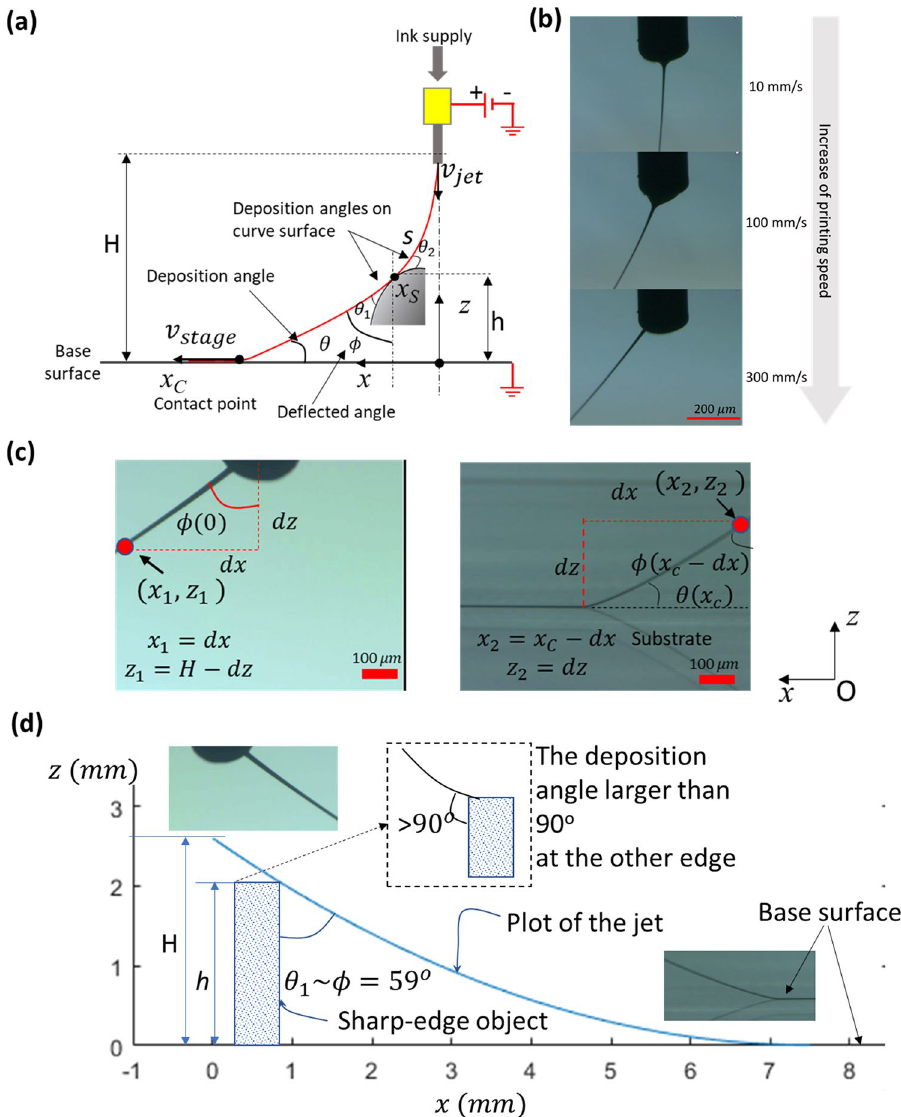
Figure 2. NFES jet deflection for 3D surface patterning. ( a ) NEFS jet deflection model for 3D surface printing. ( b ) Influence of printing speed on jet deflection shape. ( c ) Jet deflection images near nozzle and near contact point, which can be used for calculating x C , and ( d ) Jet deflection plot using parabolic model in comparison to the experimental observation. Jetting parameters: Flow rate Q = 1.5 μL/min, nozzle inner diameter d in = 150 µ m , jetting voltage V = 1,300 V, Stand-off distance H = 2.6